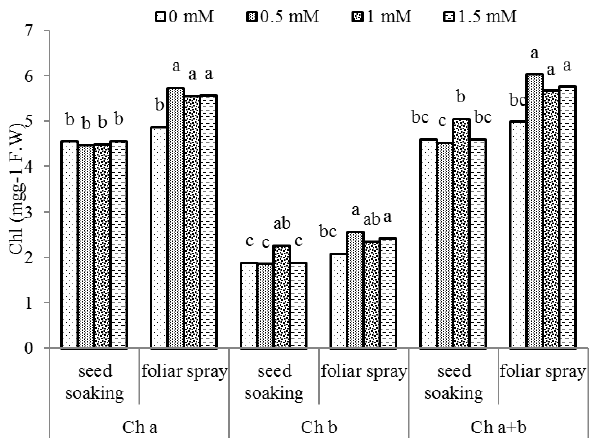
Fig. 3. Effect of SA and its application method on Chlorophyll a (Chl a), Chlorophyll b (Chl b) and Chlorophyll a + b (Chl a+b) of watermelon seedling subjected to chilling stress. Values